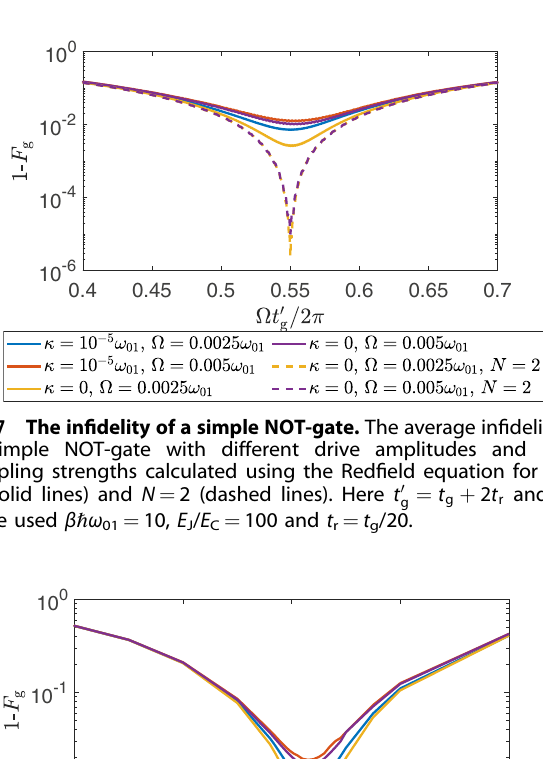
Fig. 8 The in fi delity of a DRAG NOT-gate. The average in fi delity of the DRAG NOT-gate with different drive amplitudes and bath coupling strengths calculated using Red fi eld equation. We have used N = 5, E J / E C = 100 and β ℏ ω 01 = with ε y ð t Þ ¼ (cid:2) _ ε x ð t Þ = α . The amplitude A determines the desired